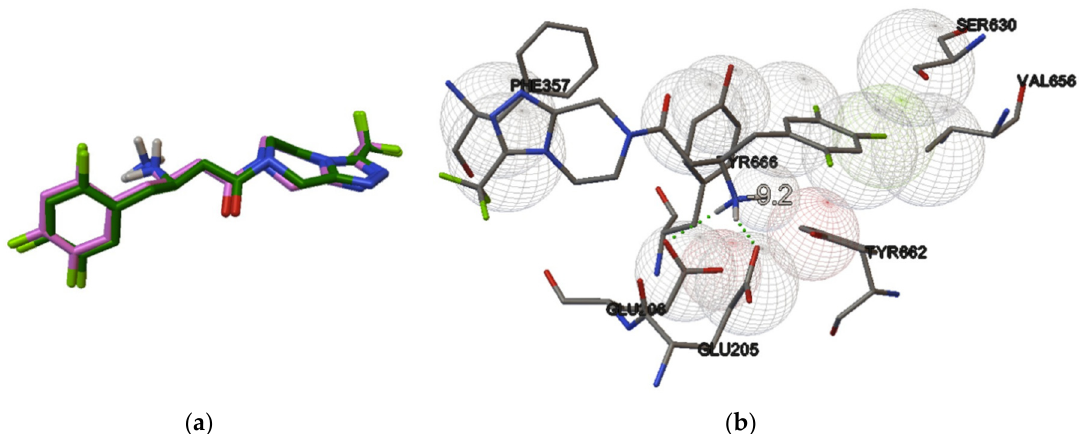
Figure 4. Validation of docking method. Superimposed structures of sitagliptin (RMSD 1.013 Å) ( a ), re-docking simulation of sitagliptin into DPP-IV. Sitagliptin forms 2 HBs with Glu 205 and Glu 206 (showed with green dotted-lines) ( b ).